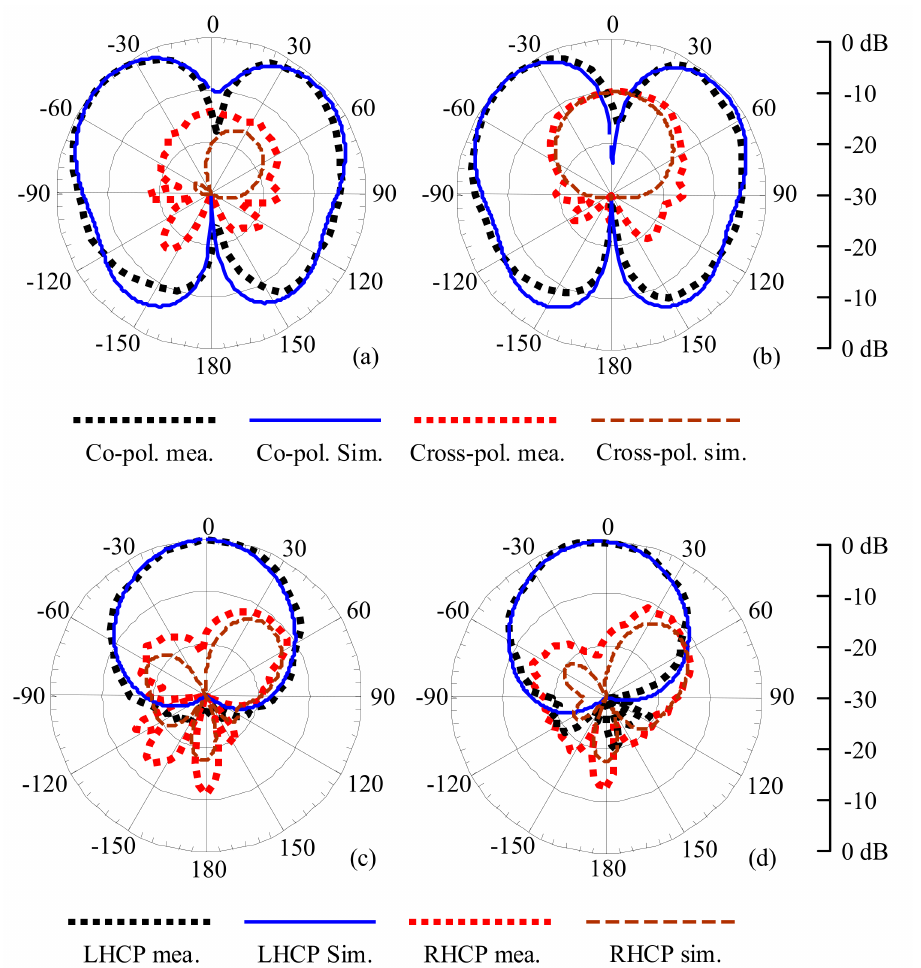
Figure 11. Normalized radiation pattern. ( a ) E-plane at 3.55 GHz. ( b ) H-plane at 3.55 GHz. ( c ) E-plane at 5.5 GHz. ( d ) H-plane at 5.5